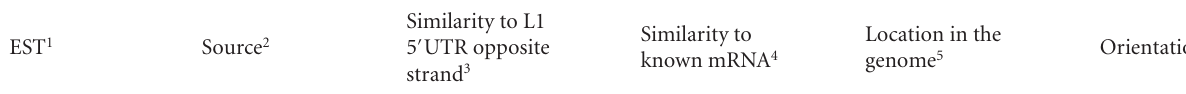
Table 3: Examples of the L1 ASP functioning as an alternative promoter or driving antisense transcription of human genes.